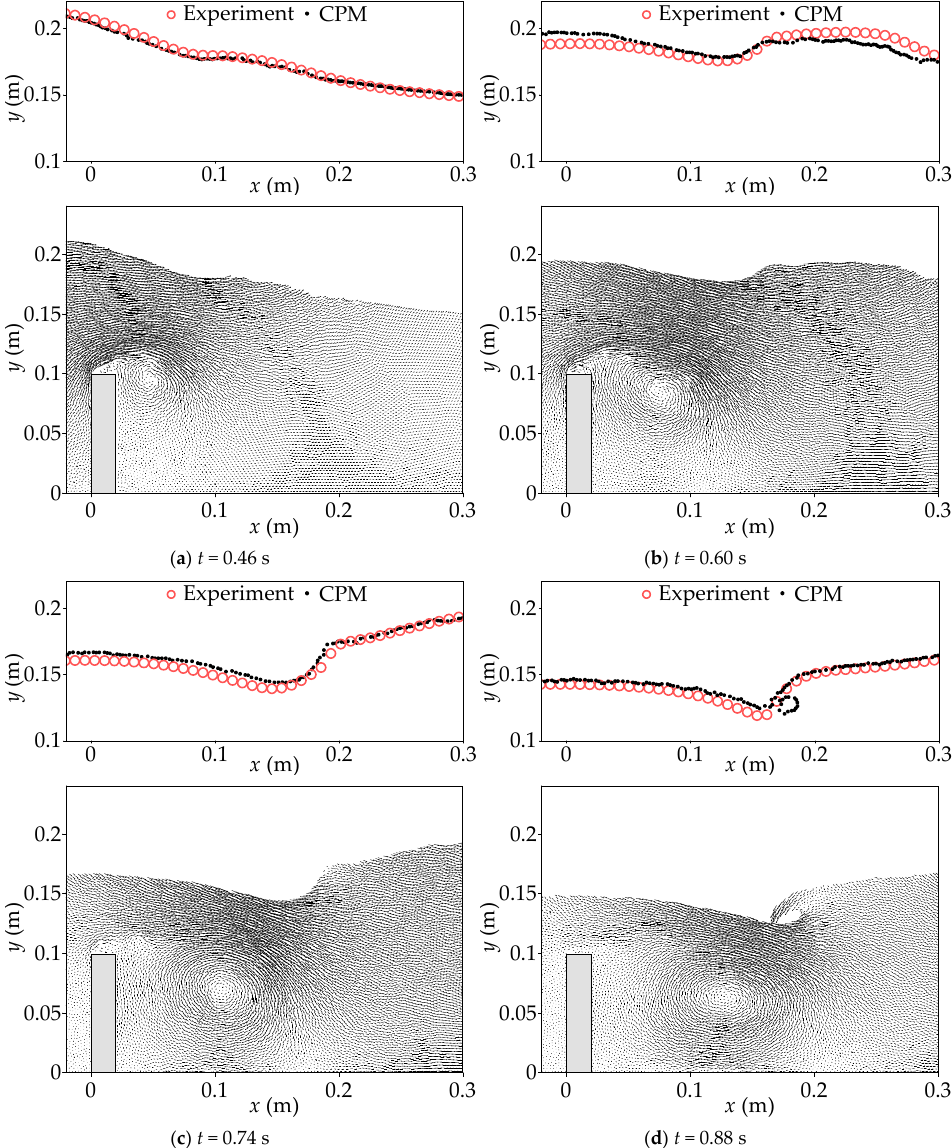
Figure 3. Wave profiles and velocity fields at typical time instants: ( a ) t = 0.46 s; ( b ) t = 0.60 s; ( c ) t = 0.74 s; ( d ) t = 0.88 s.